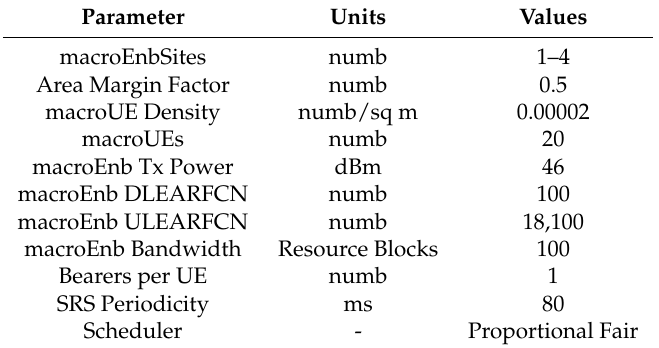
Table 5. Parameters with their units and values adopted from 3GPP R4-092042 specification for